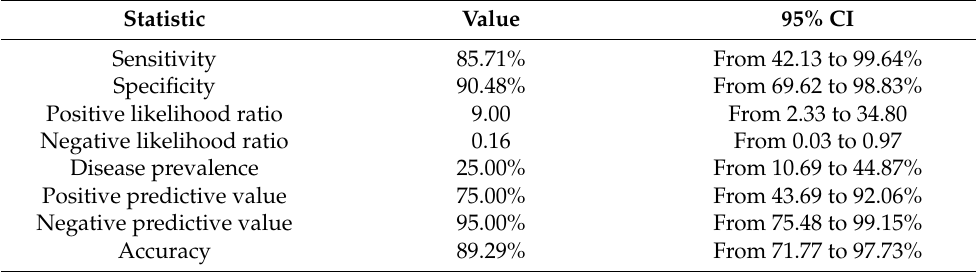
Table 7. Statistical analysis of preeclampsia prediction using the proposed LC-MS/MS method in the 36th week of pregnancy. CI—confidence